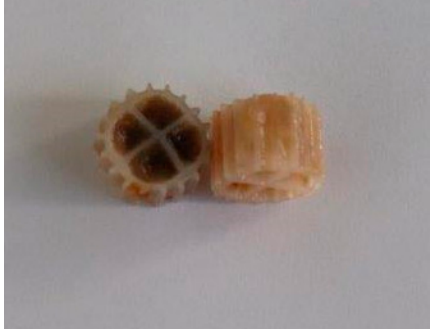
Figure 2. Photograph of AnoxKaldnes rings.